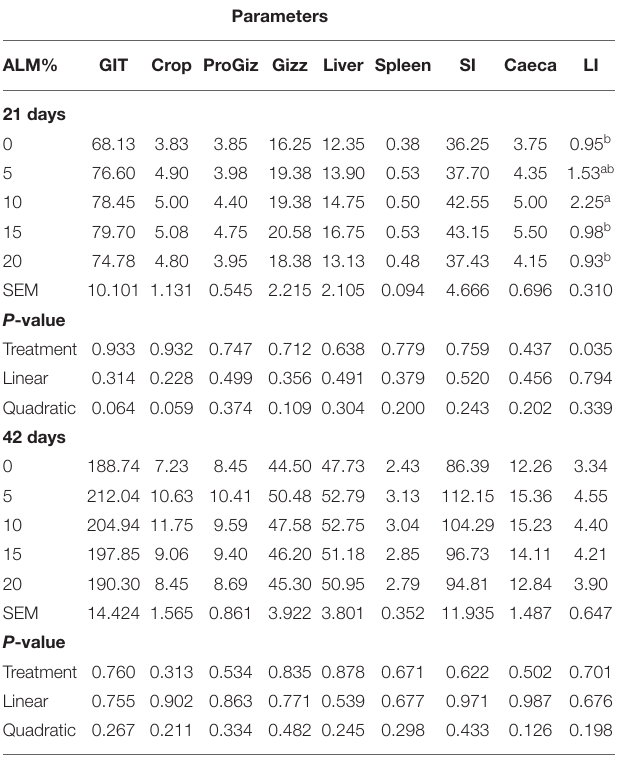
TABLE 7 | Relationships between amaranth leaf meal inclusion and essential amino acids digestibility. Parameter